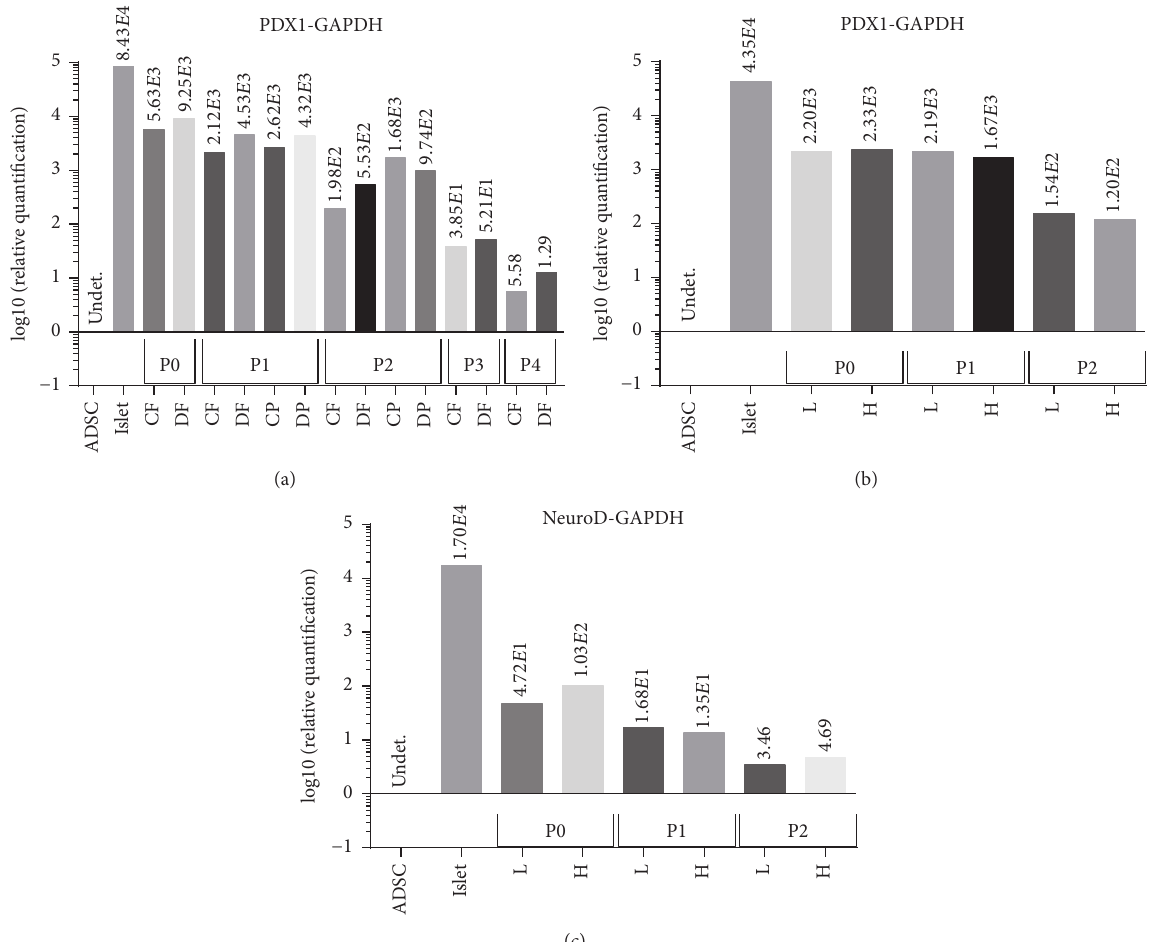
Figure 4: Pdx1 and NeuroD mRNA expression in islet-derived cells cultured with different media. Analysis of gene expression (mRNA) using qRT-PCR was performed on cells isolated from different pigs and representative results are presented. (a) Islet-derived cells were cultured in media as described in Figure 3(a) and analyzed for the expression of Pdx1 mRNA. (b, c) Islet-derived cells were cultured in media as described in Figure 3(b) and analyzed for the expression of Pdx1 (b) and NeuroD (c) mRNA. The results are the average fold increase for each indicated mRNA compared with the level of this mRNA in adipose-derived stem cells (ADSC) and normalized for the expression of